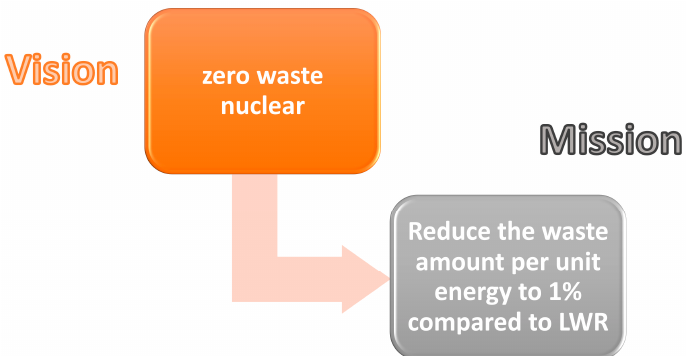
Figure 7. Translating the vision of zero waste nuclear into a viable mission.